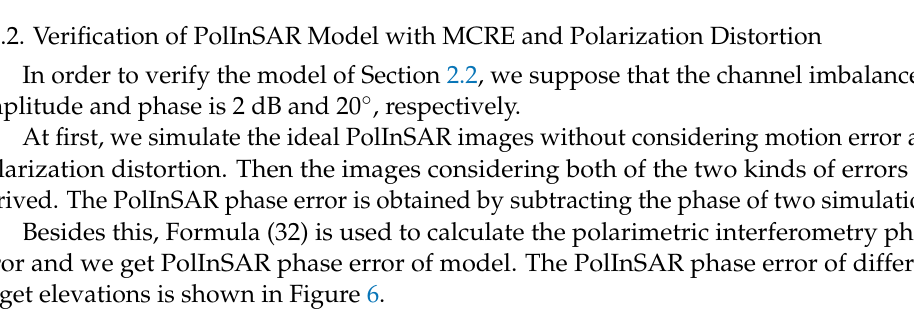
Figure 5. ( a ) SAR Image of a stadium lawn. ( b ) Amplitude of HH echo of a surface